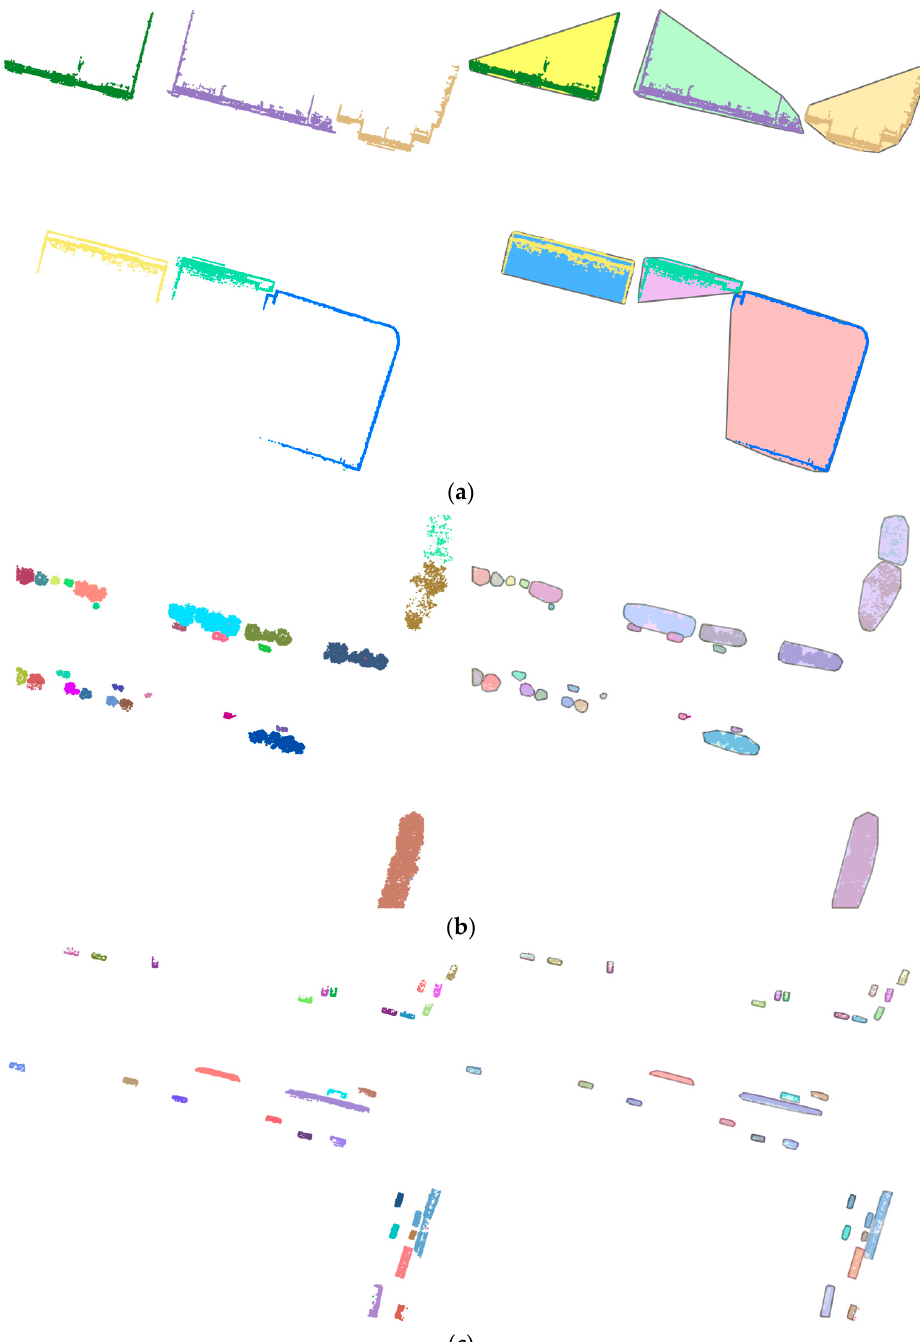
Figure 7 . Horizontal hollow ratio-based building point identification ( a – c ). Left : top view of segments of point clouds of several buildings, trees and cars. Right : overlay of a convex hull and point clouds of each segment.